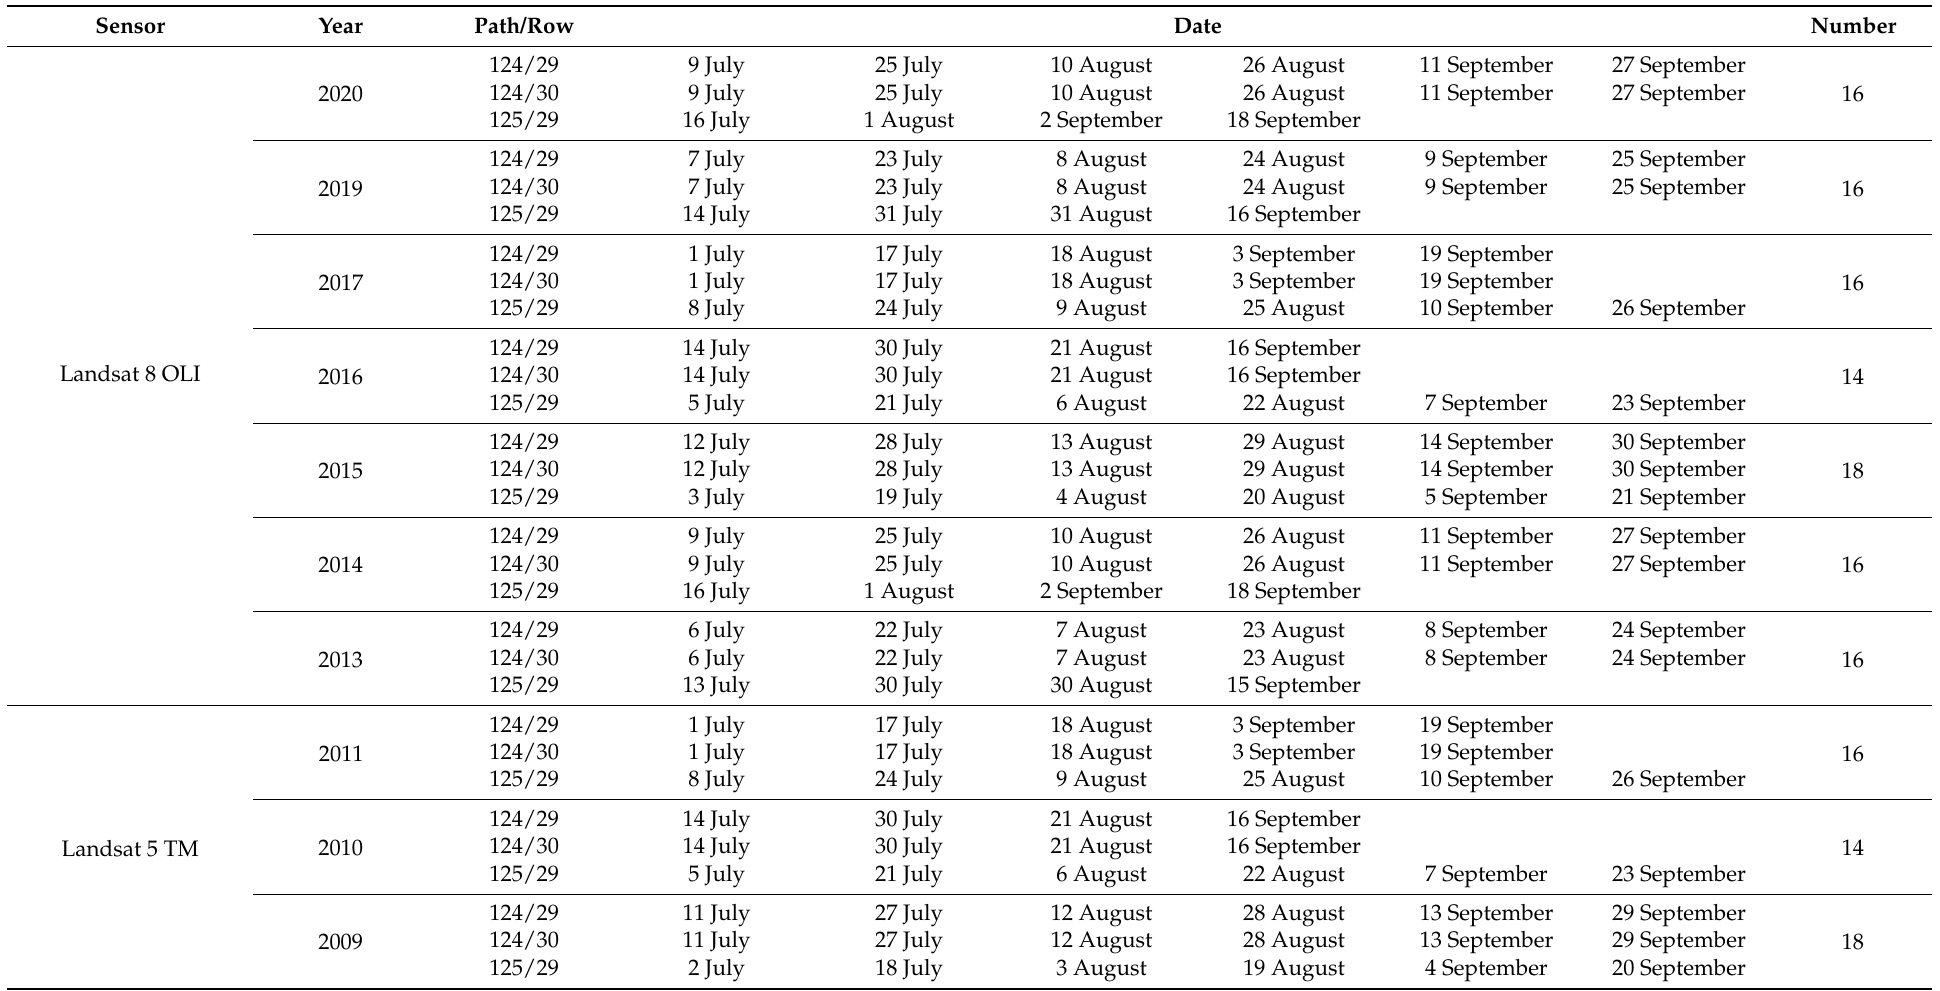
Table 1. Information of satellite